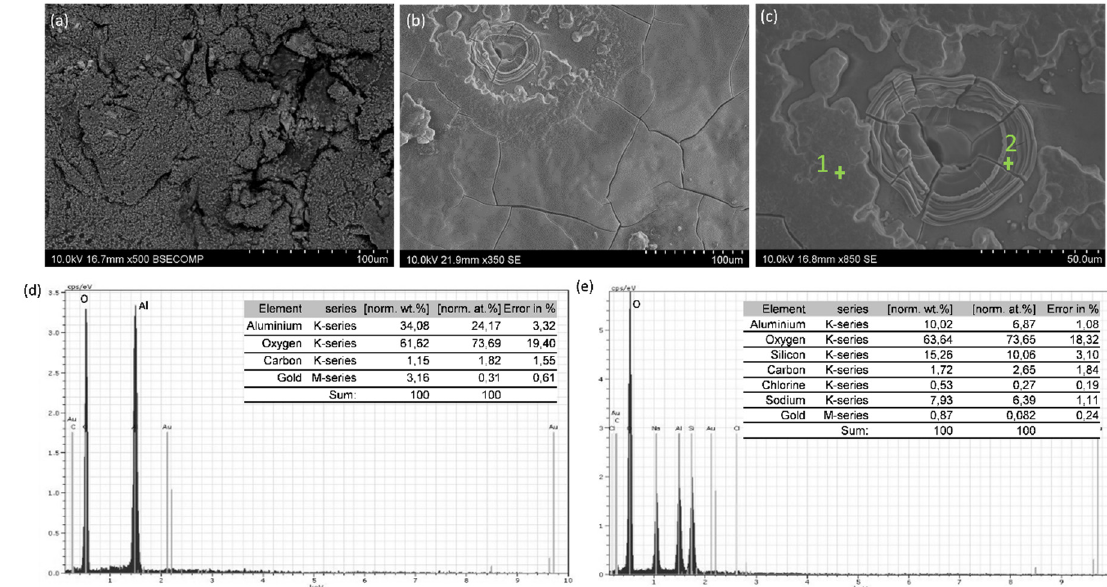
Figure 6. SEM images of the surface of the Al40Si/SiC coating after 168 h of immersion in 3.5 wt.% NaCl: ( a ) and ( b ) general view of two different zones of the surface; ( c ) detail of (b); ( d ) EDS analysis of point 1 in (c); and ( e ) EDS analysis of point 2 in (c).